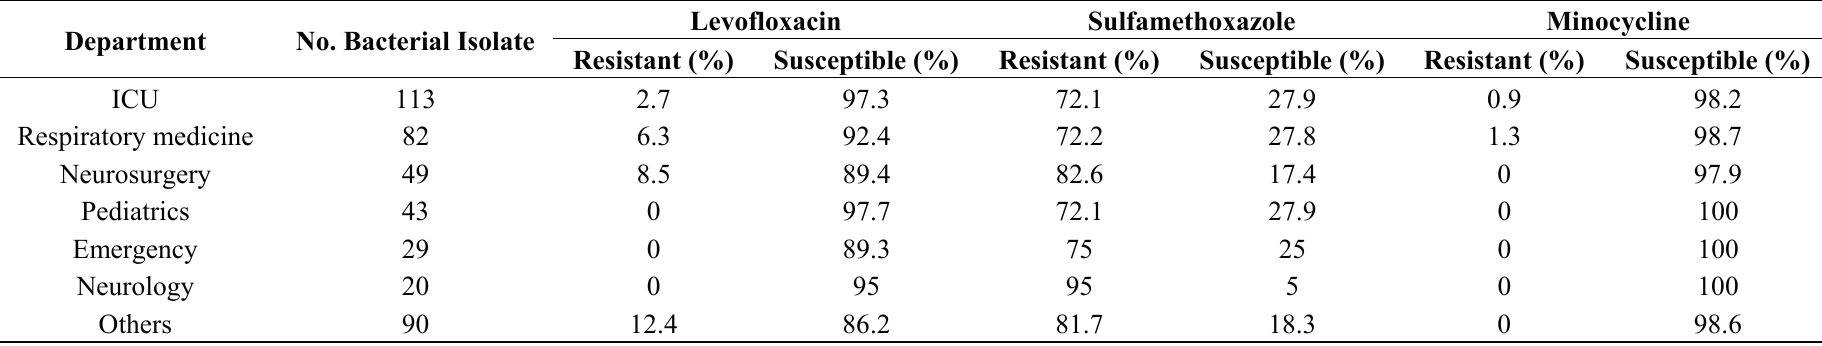
Table 3. Resistance to three fluoroquinolone antibacterial drugs in Stenotrophomonas maltophilia isolated from various departments of the hospital. Department